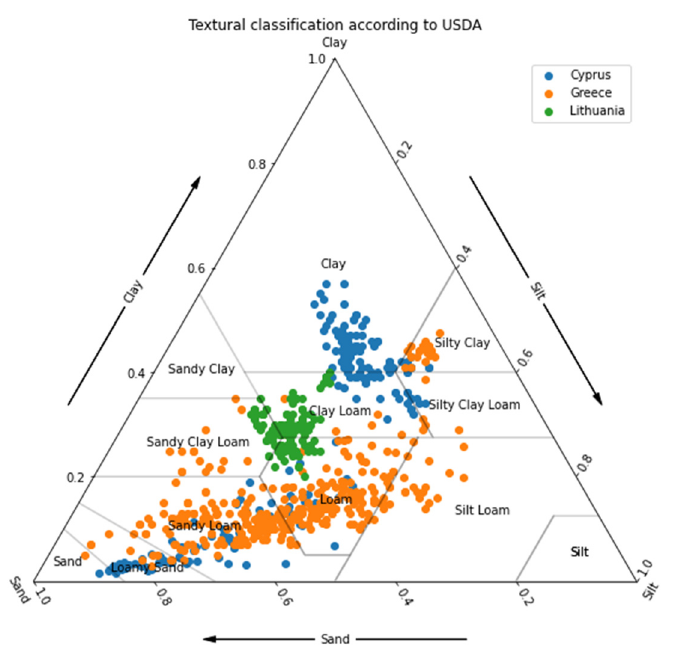
Figure 5. Soil sample’s textural classification according to the USDA.